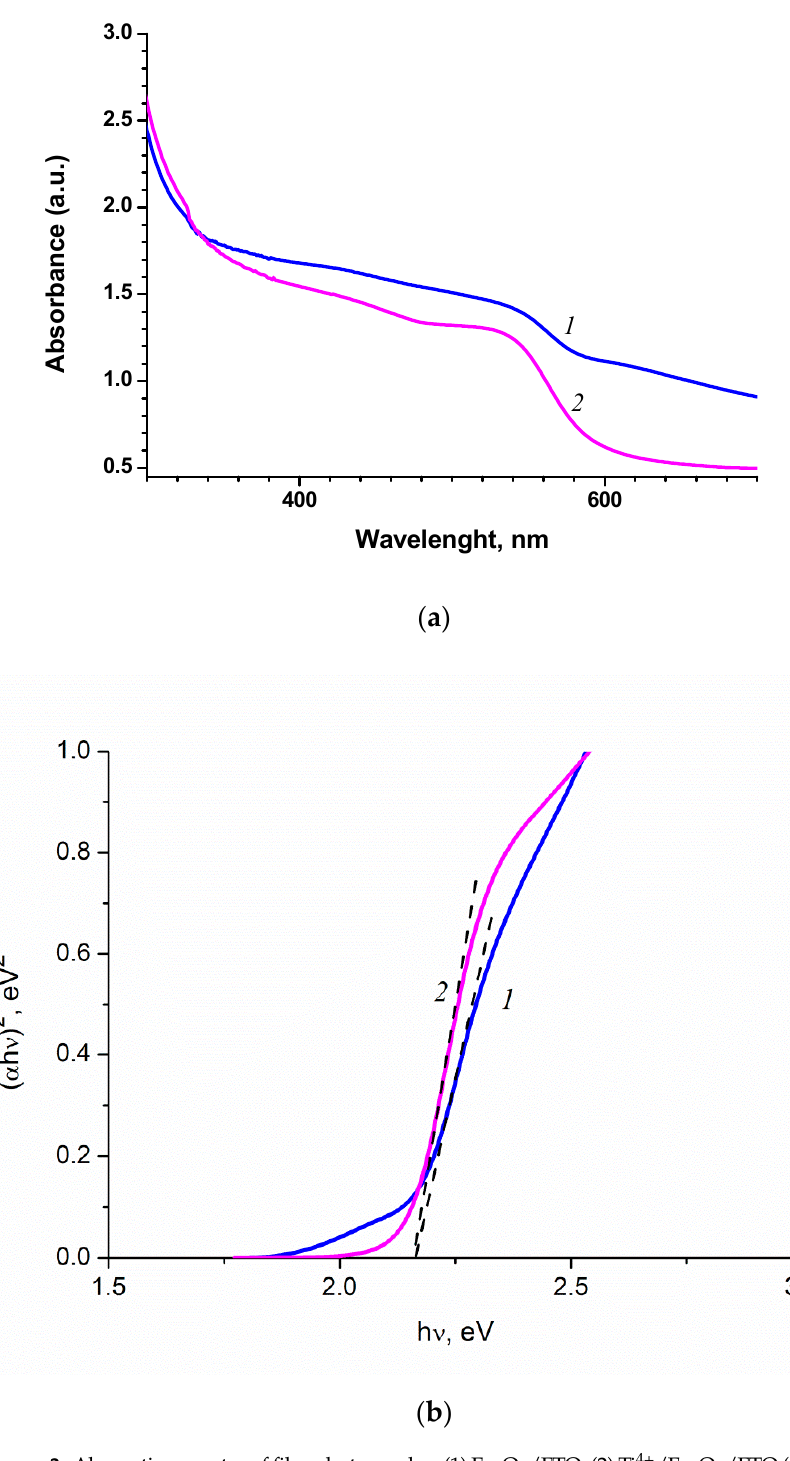
Figure 3. Absorption spectra of film photoanodes: (1) Fe 2 O 3 /FTO; (2) Ti 4+ /Fe 2 O 3 /FTO ( a ) and dependence of ( α hv ) 2 on photon energy h ν for film photoanodes: (1) Fe 2 O 3 /FTO; (2) Ti 4+ /Fe 2 O 3 /FTO ( b ).